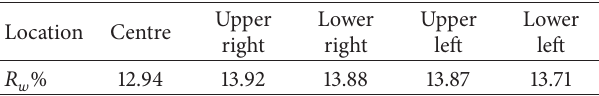
and uniformity between POCl sheet